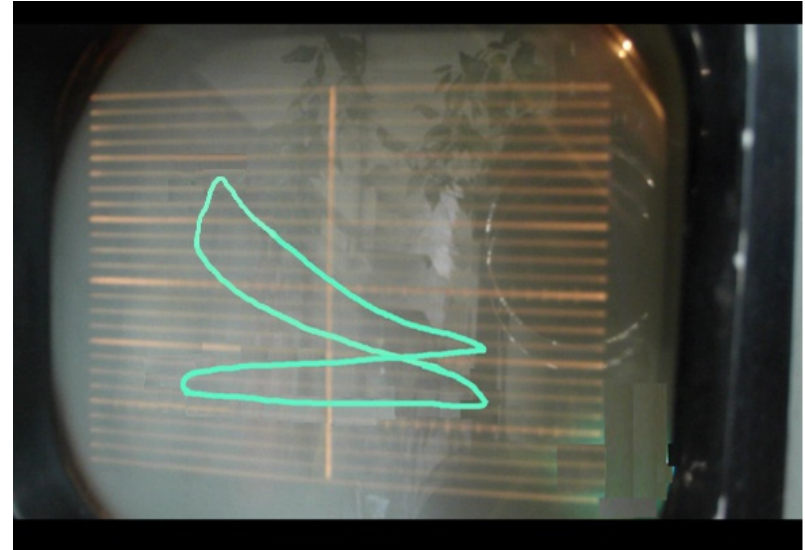
Figure 3. Indicated PV diagram for HCCI combustion mode.